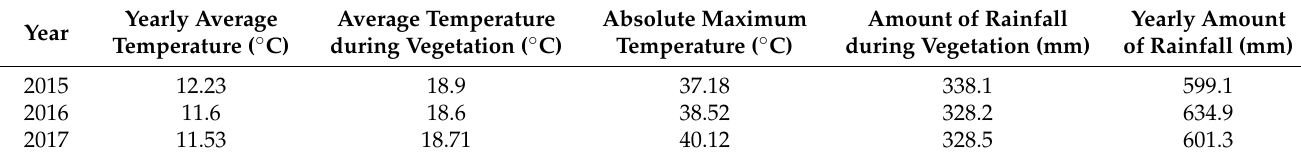
Table 1. Local meteorological values of the years of